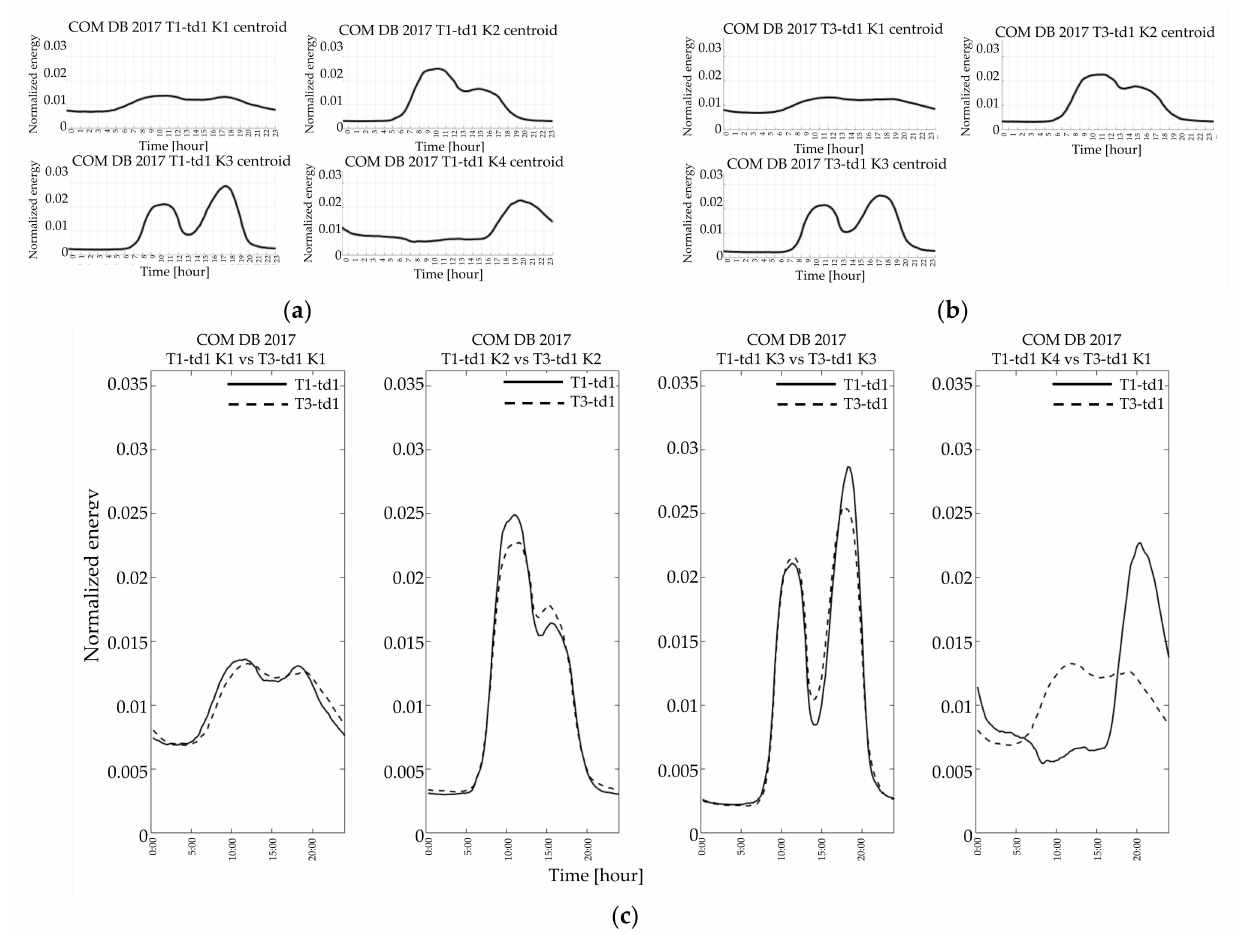
Figure 9. Database 2017, commercial (COM) end-users, normalized centroids: ( a ) winter workdays (four clusters), ( b ) summer workdays (three clusters), ( c ) comparison between the two typical days.